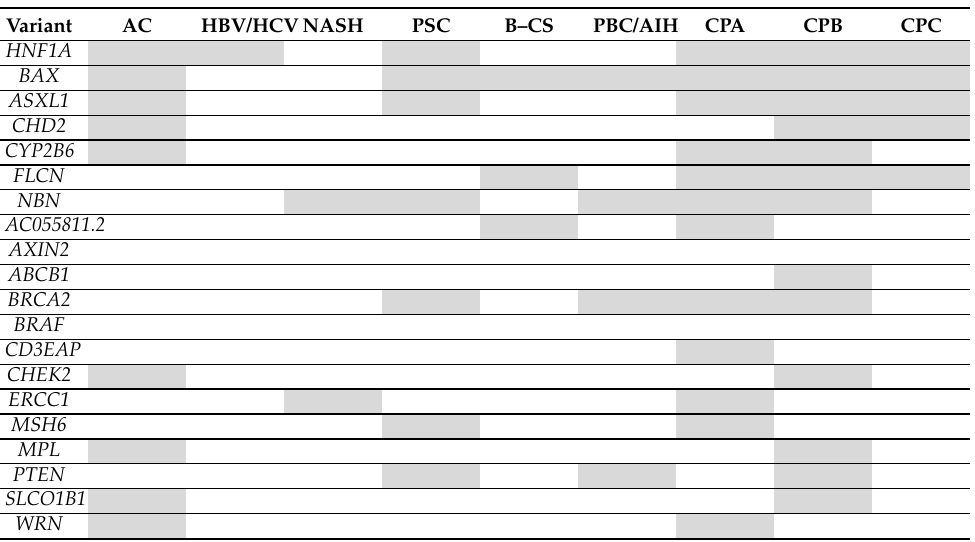
Table 8. Distribution of variants with respect to